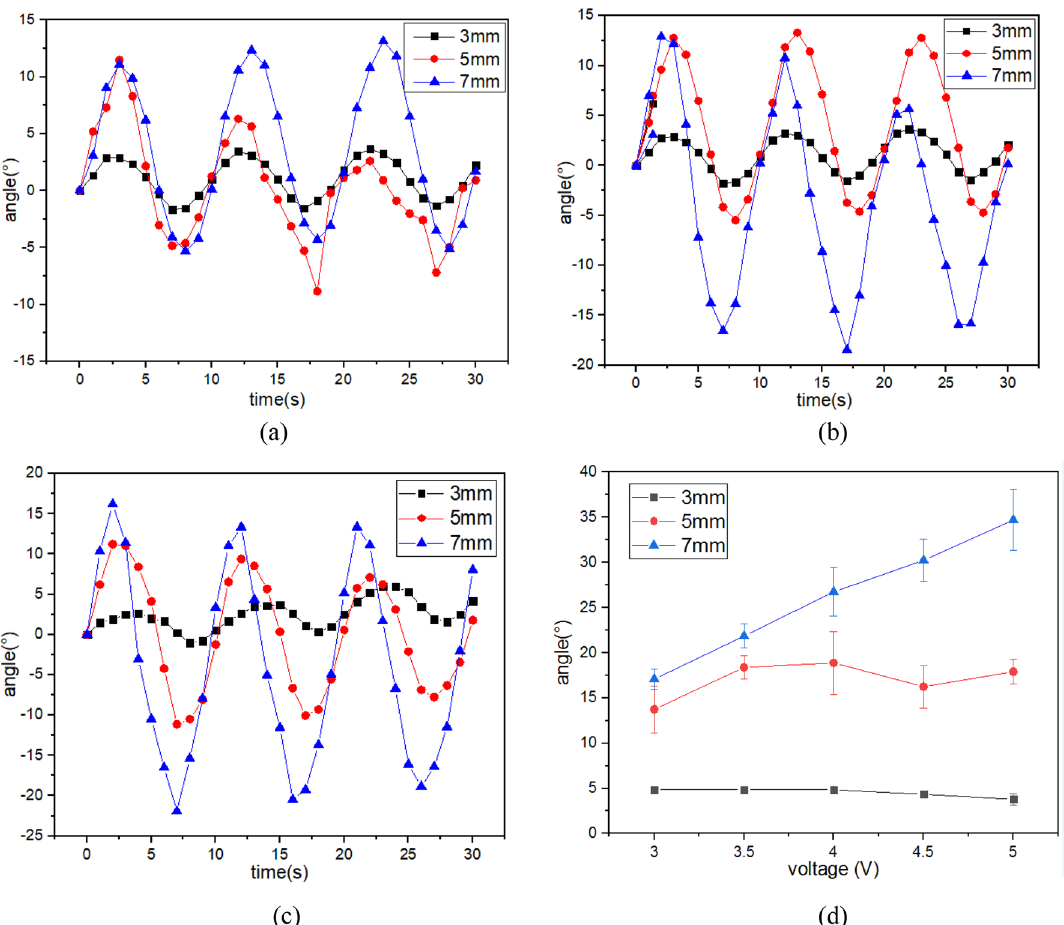
Figure 4. The twist angle of IPMC with patterned electrodes under 0.1 Hz AC Voltage. ( a ) 3v, ( b ) 4v ( c ), 5v ( d ) peak-valley angle under different